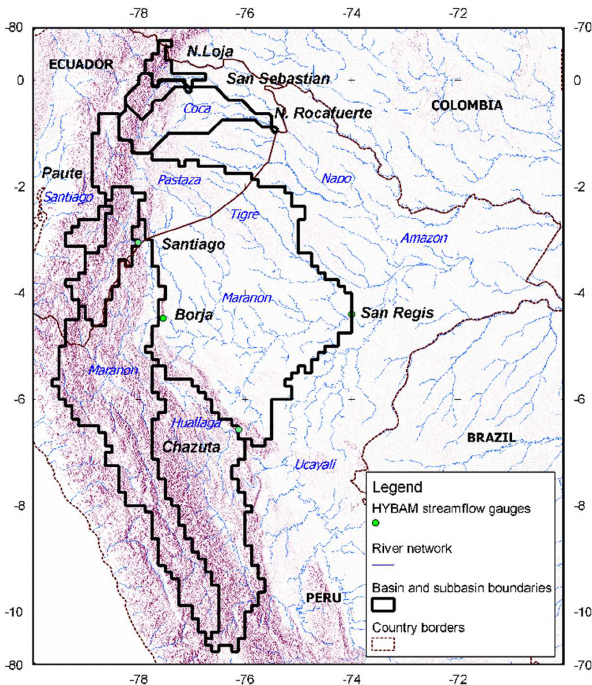
Fig. 1. The Peruvian Amazon basin. The Mara˜n´on River merges with Ucayali River from the south and Napo River from the north beyond the downstream limits of the basin to form the Amazon proper river. The basin relief (in red) shows the location of the Andean ranges where the climate and physiography are highly variable.